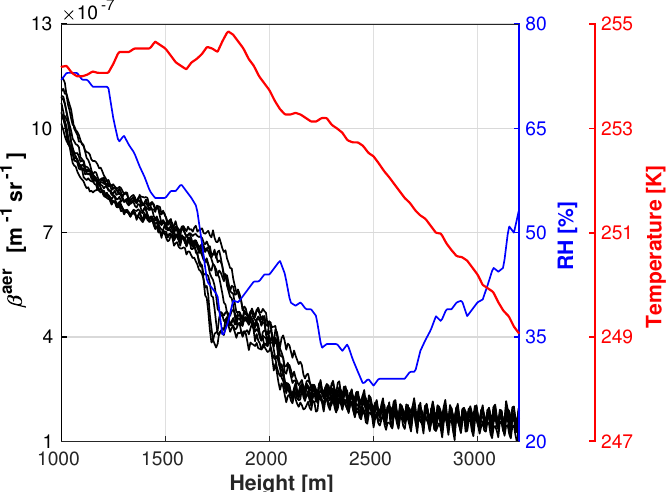
Figure 9. Atmospheric conditions on 21 February 2020. Meteorological data RH (in blue) and temperature (in red) from RS launch at 10:58UTC, and lidar data β aer from (13:40–15:10)UTC (in black). The resolution of the lidar data is 10 min and 7.5